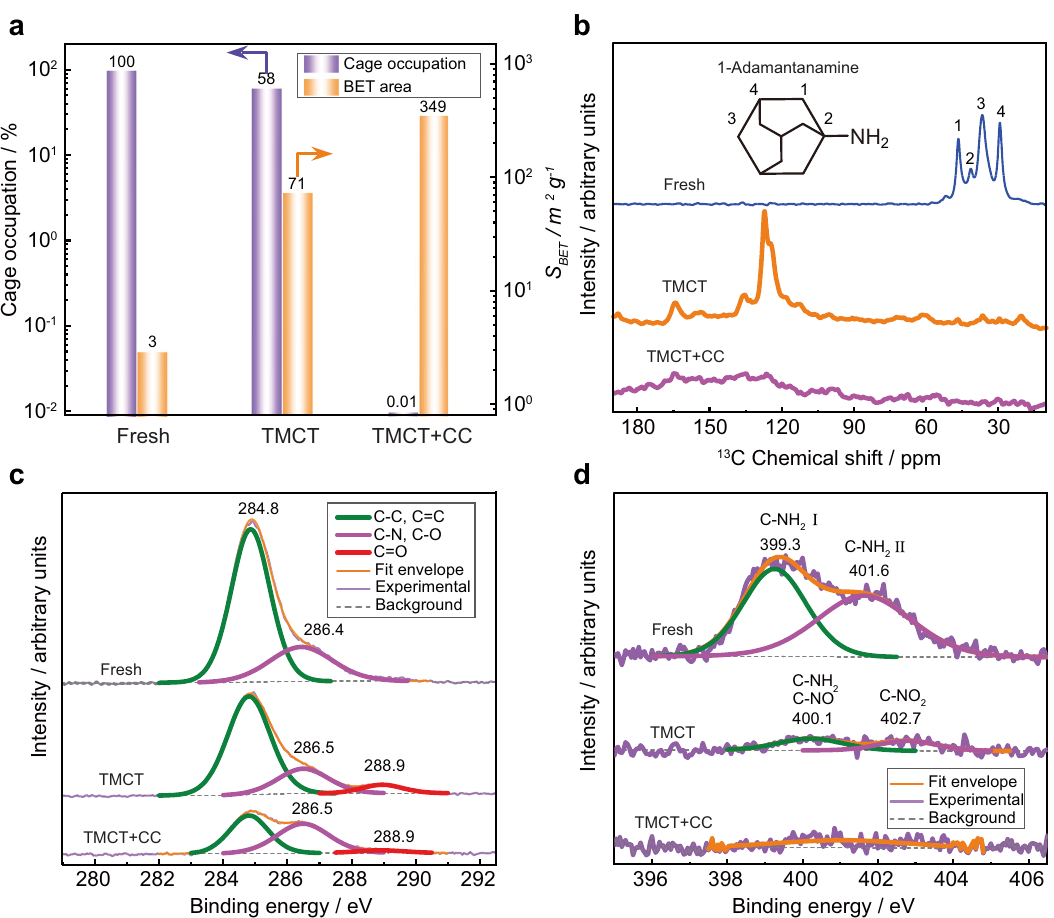
Fig. 2 Template decomposition process in TMCT approach. a BET area and cage occupation in DD3R zeolite. b 13 C NMR spectra; c C 1 s XPS spectra; d N 1 s XPS spectra. Fresh, as-synthesized zeolite; TMCT, overheating at 700 °C for 1 min; TMCT + CC, 700 °C for 1 min followed by 550 °C calcination for 10 h. Source data are provided as a Source Data fi le.